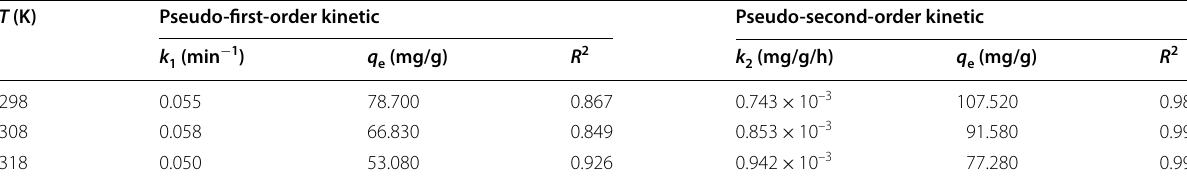
Table 3 Kinetic parameters for the adsorption of chromium (VI) T (K) Pseudo‑first‑order kinetic Pseudo‑second‑order kinetic